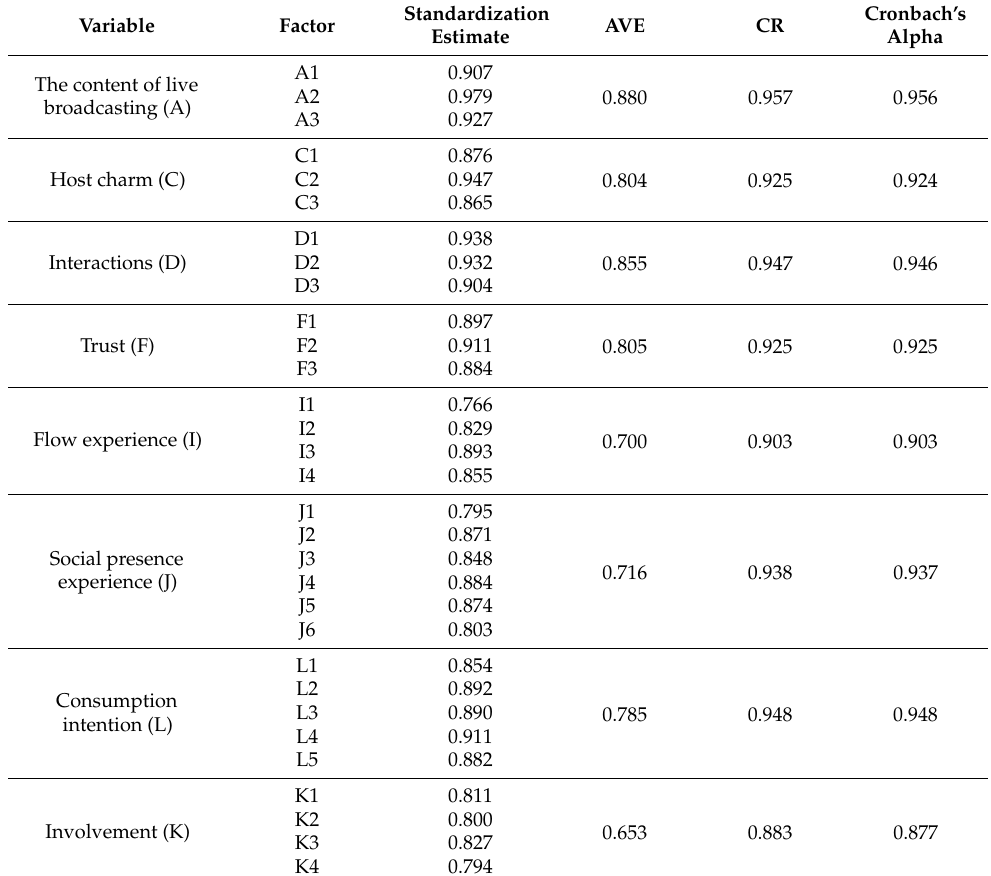
Table 1. Reliability and convergence validity of the scale.